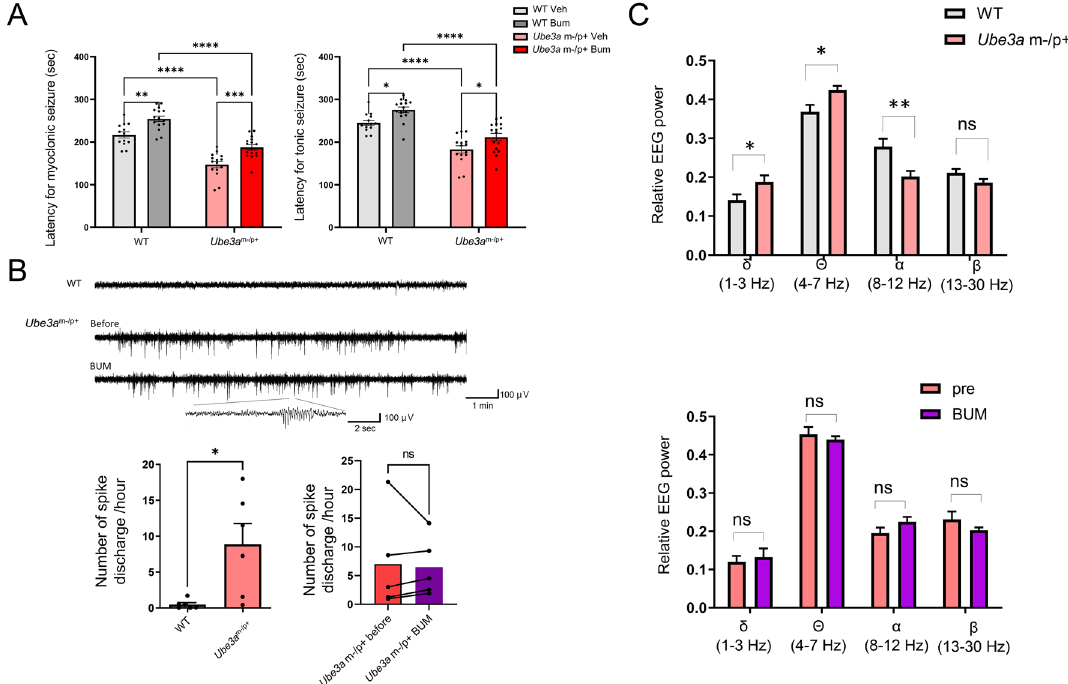
Figure 4. Effects of bumetanide on epileptic features of Ube3a m−/p+ mice. ( A ) Effects of bumetanide on seizure susceptibility induced by flurothyl inhalation. The left and right panels indicate the latencies of myoclonic and tonic seizures, respectively. Bumetanide increases the latency of seizure induction in both wild-type (WT) and Ube3a m−/p+ mice. * p < 0.05; ** p < 0.01; *** p < 0.001; **** p < 0.0001 by post-hoc analysis after two-way ANOVA . n = 15–18 for each group. ( B ) Effects of bumetanide on epileptic discharges in Ube3a m−/p+ mice. The upper panel shows representative encephalography (EEG) traces taken during the awake state. The left lower panel demonstrates the significantly higher probability for epileptic spike discharges in Ube3a m−/p+ mice (n = 6) compared to WT animals (n = 6). * p < 0.05 by the unpaired t test. The right lower panel shows the probabilities of epileptic spike discharges before and after bumetanide administration in Ube3a m−/p+ mice (n = 5). ns not significant by the paired t test. ( C ) Effects of bumetanide on the relative EEG power spectrum in Ube3a m−/ p+ mice. The upper panel shows the comparison of relative EEG powers in each band during the awake state between WT (n = 11) and Ube3a m−/p+ (n = 11) groups. * p < 0.05; ** p < 0.01 by the unpaired t test. The lower panel shows the relative EEG powers in each frequency band before and after bumetanide administration in Ube3a m−/ p+ mice (n = 5). ns not significant by the paired t test. Bumetanide does not affect the EEG abnormalities of Ube3a m−/p+